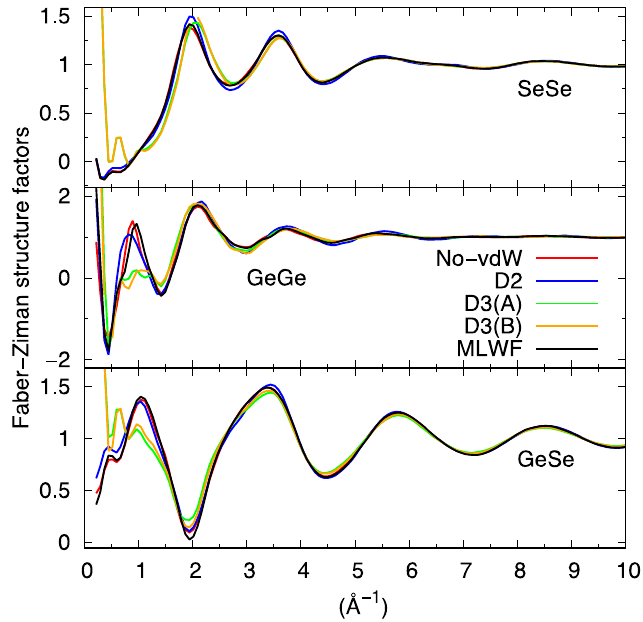
Figure 6. Partial structure factors for liquid GeSe 4 obtained via integration of the partial pair correlation functions.